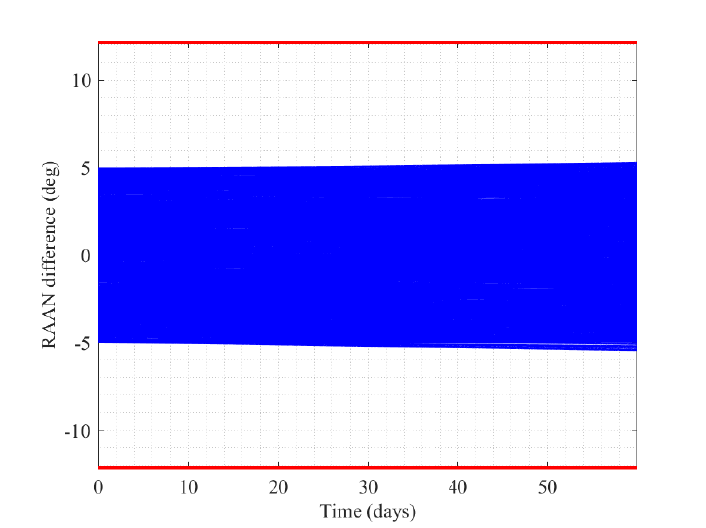
Figure 26. RAAN differences of constellation satellites. Red lines represent δ Ω min and δ Ω max respectively. Blue lines represent RAAN differences.